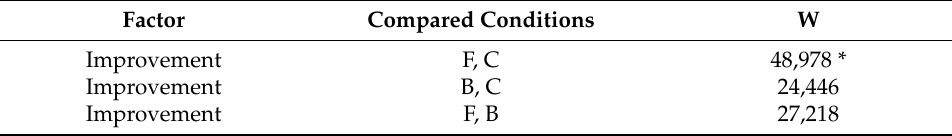
Table 5. Post-hoc Mann–Whitney tests results for the variable “Improvements”. Factor Compared Conditions W Improvement F, C 48,978 * Improvement B, C 24,446 Improvement